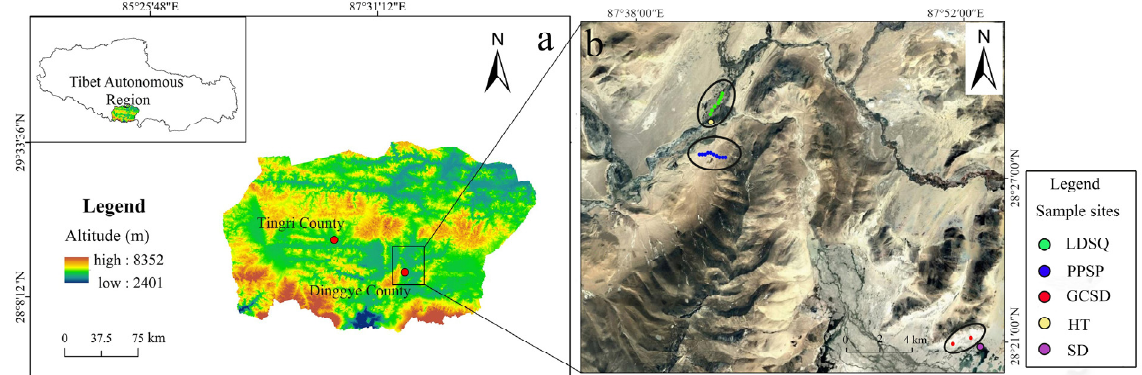
Figure 1. Location of the study area and sampling sites: ( a ) is the map of the Dinggye area and the Tibet Autonomous Region, and ( b ) is the location diagram of sampling points (image modified from Google Earth).